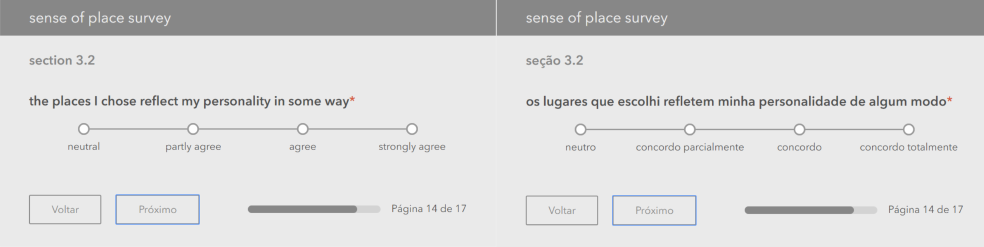
Figure 16: Likert question for place identity.